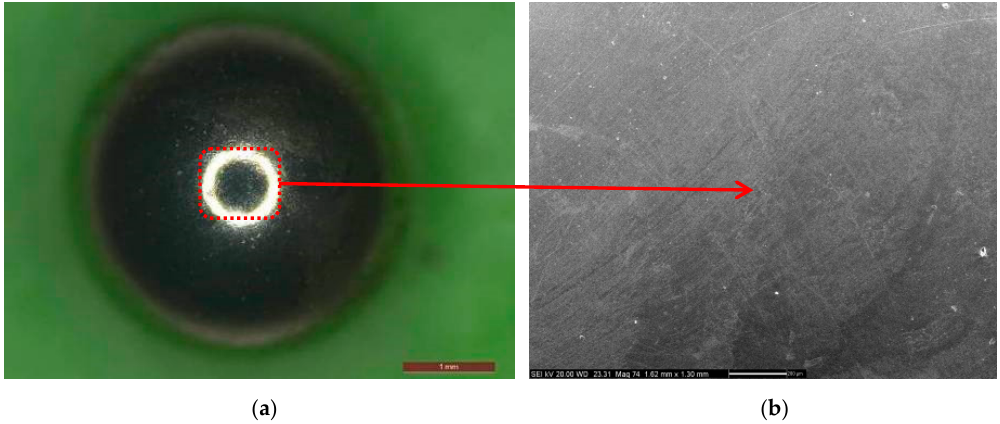
Figure 7. Typical light damage appearance of the balls: ( a ) macroscopic appearance of the wear; ( b ) microscopic appearance of the wear.